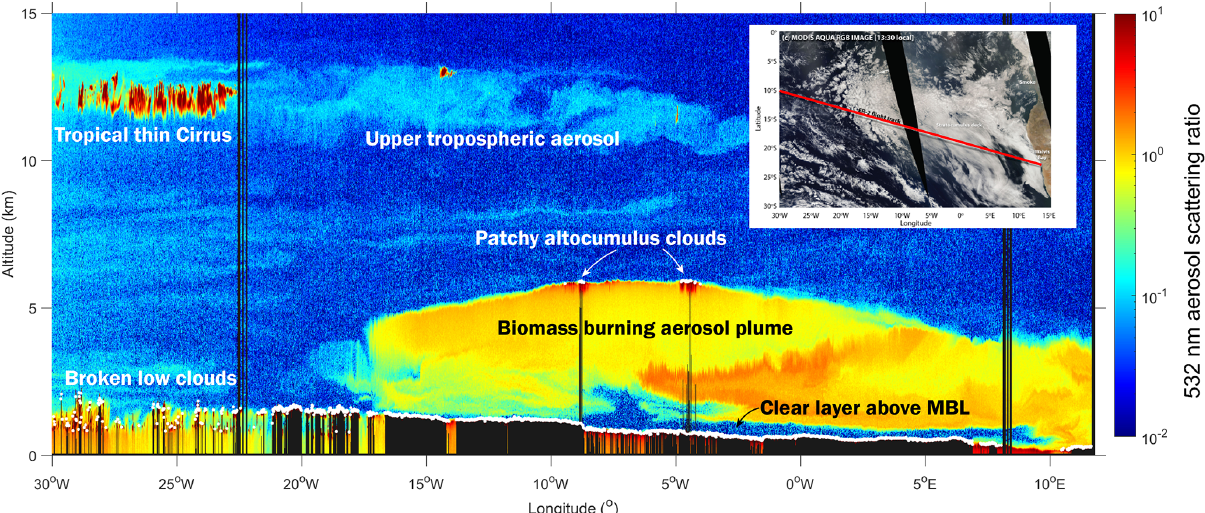
Figure 22. Longitudinal cross section of the HSRL-2 scattering ratio curtain collected during the ER-2 transit from Recife, Brazil, to Walvis Bay, Namibia, on 26 August